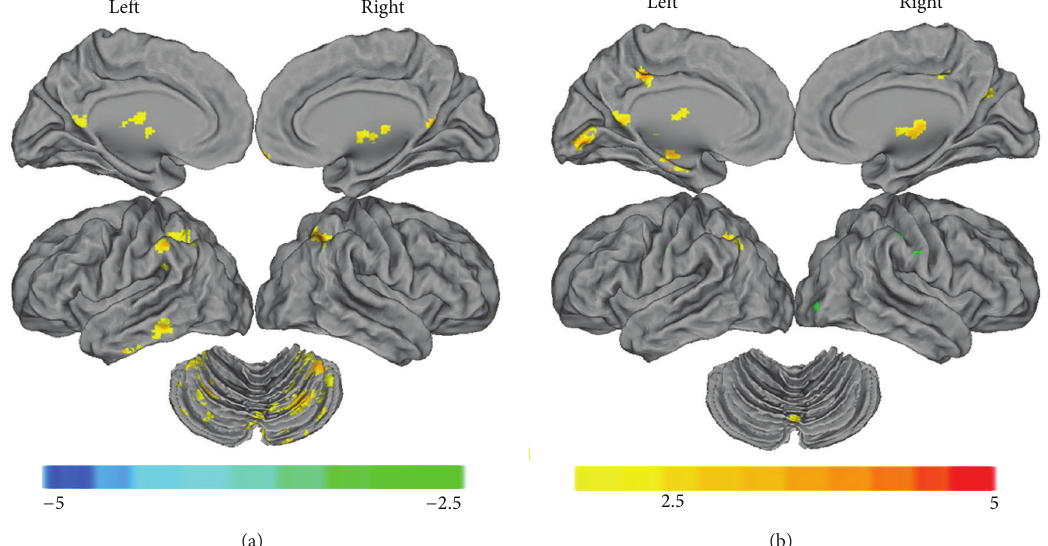
Figure 2: The anatomical distribution of the alterations in functional connectivity with the left primary visual cortex (a) and the right primary visual cortex (b) in mixed amblyopic subjects is shown in comparison with normal sighted controls, as individually visualized using the Caret = 0.01 ). A detailed introduction of the brain regions can be found in Tables v5.61 software ( 𝑃 < 0.01 , 130 voxels, AlphaSim corrected 𝑃 alpha S4 and